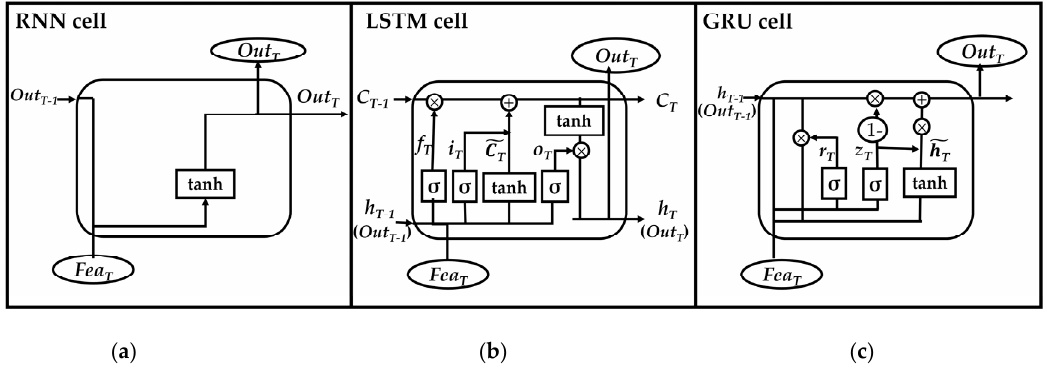
Figure 6. Comparison of Recurrent Neural Network (RNN), Long Short ‐ Term Memory (LSTM), and Gated Recurrent Unit (GRU): ( a ) RNN; ( b ) LSTM; ( c ) GRU.